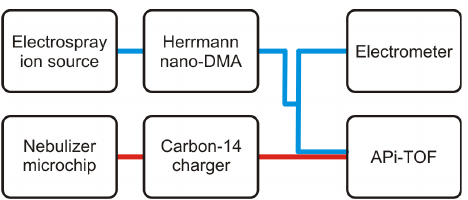
Fig. 2. Schematic laboratory setup used in this work. In the first tests (blue trace) electrosprayed mobility standards were mobility Fig. 3. Schematic laboratory setup used in this work. In the first selected and passed to both an electrometer and the APi-TOF. In tests (blue trace) electrosprayed mobility standards were mobility theothersetup(redtrace),thesamplewasproducedbyamicrochip nebulizer and charged in a beta charger before reaching the APi- selected and passed to both an electrometer and the APi-TOF. In TOF. For atmospheric ion measurements, the APi-TOF measured directlyfromtheambient. the other setup (red trace), the sample was produced by a microchip nebulizer and charged in a beta charger before reaching the APi- TOF. For atmospheric ion measurements, the APi-TOF measured directly from the ambient.